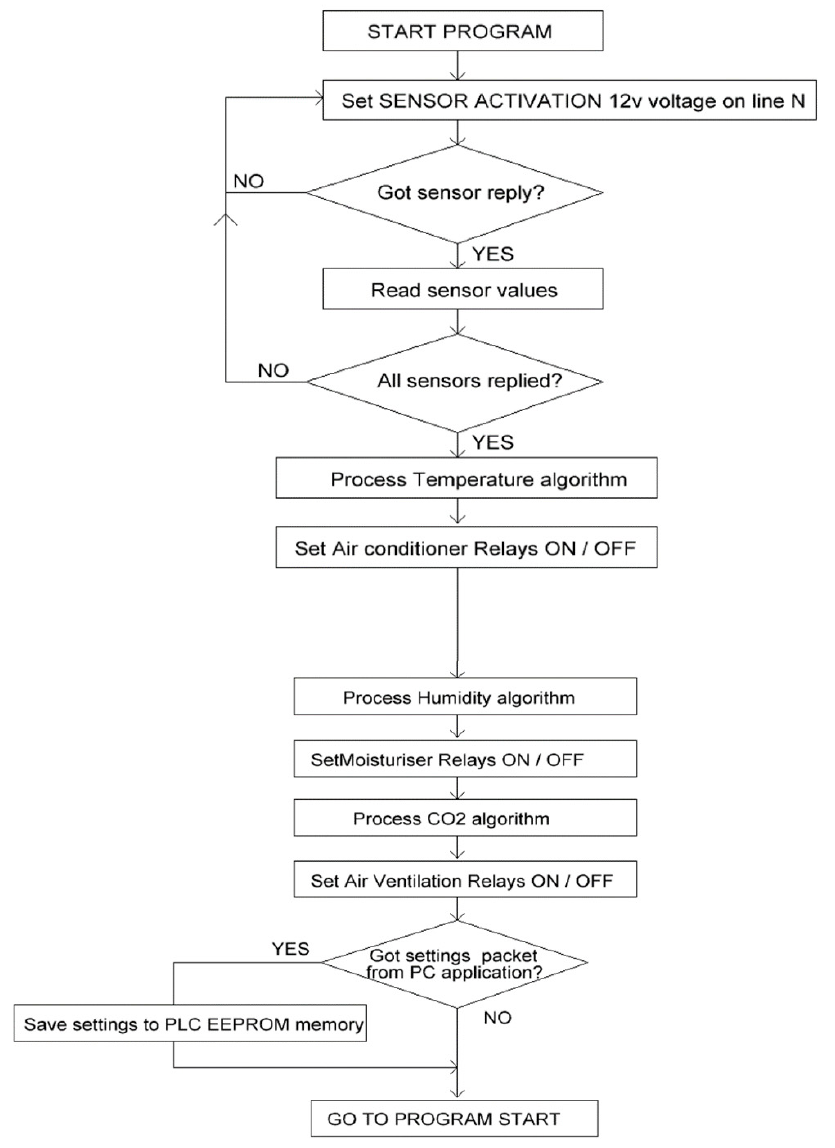
Figure 5. The algorithm of the program of the automatic system of maintaining conditions for growing mushrooms.